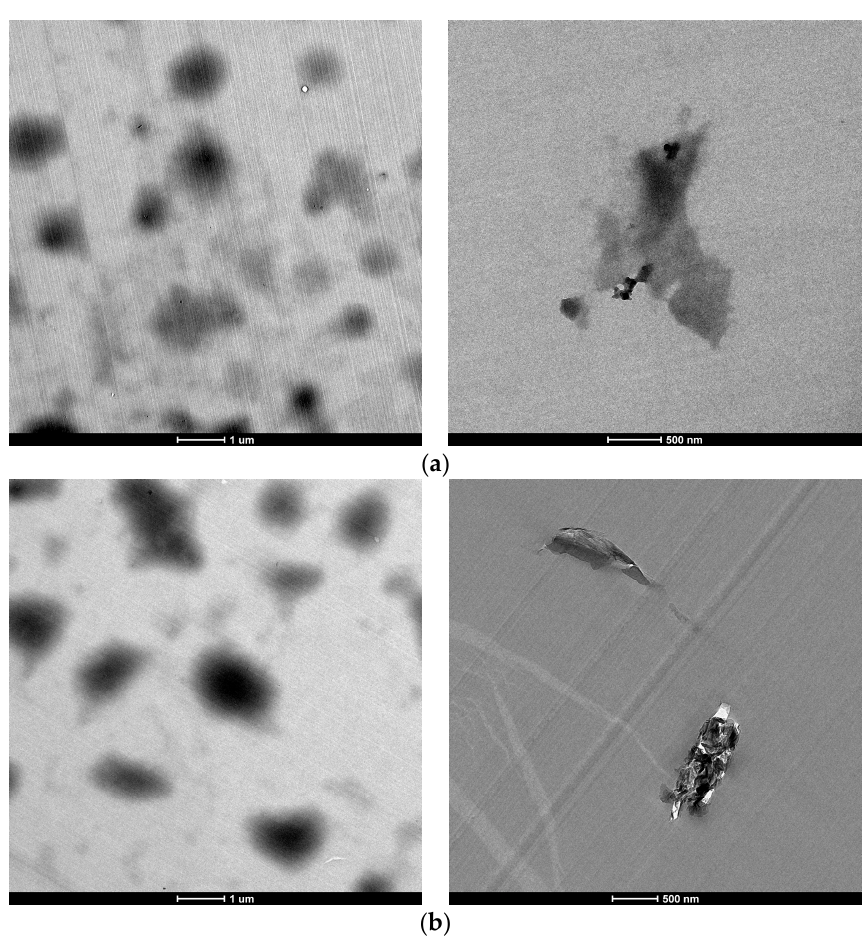
Figure 10. TEM images of epoxy/graphene composites with 0.5 wt % of: ( a ) GO and ( b ) rGO.